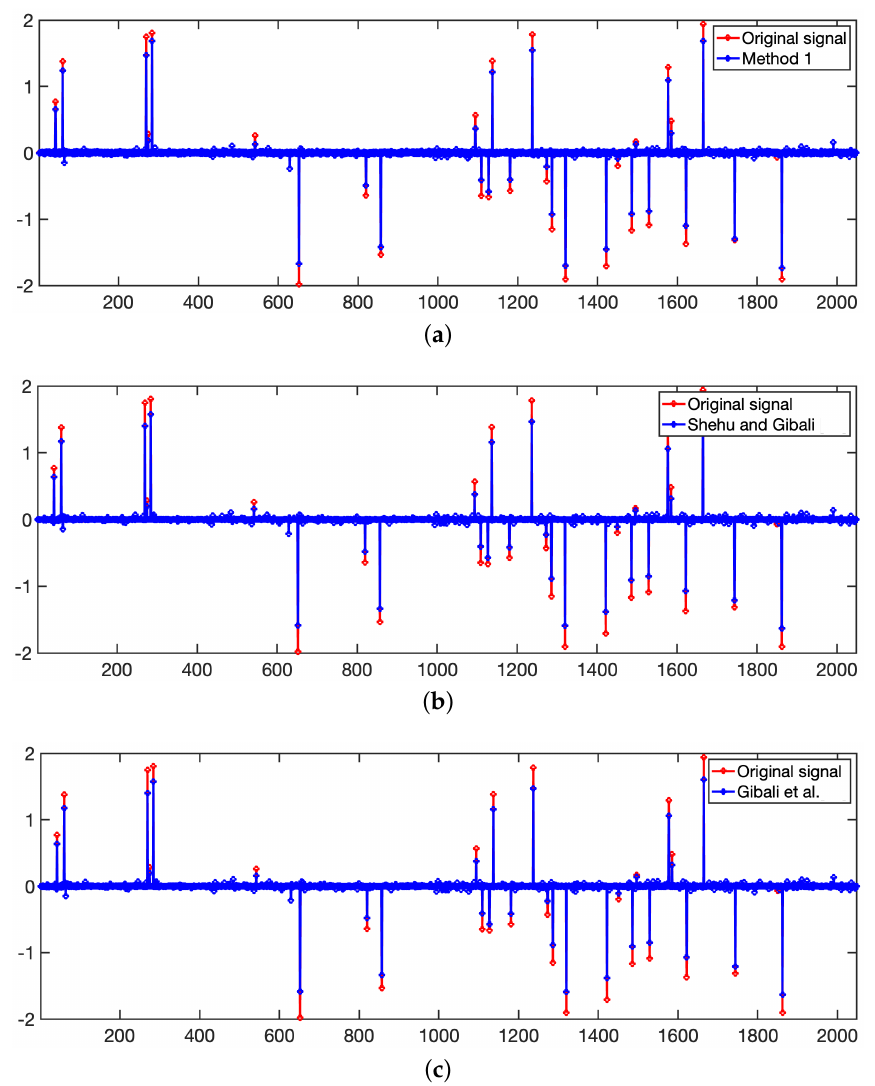
Figure 5. Original signal and recovered signal by Method 1, algorithm of Shehu and Gibali and algorithm of Gibali et al., respectively, when P = 2048, K = 1024, m = 30 and MSE < 10 − 3